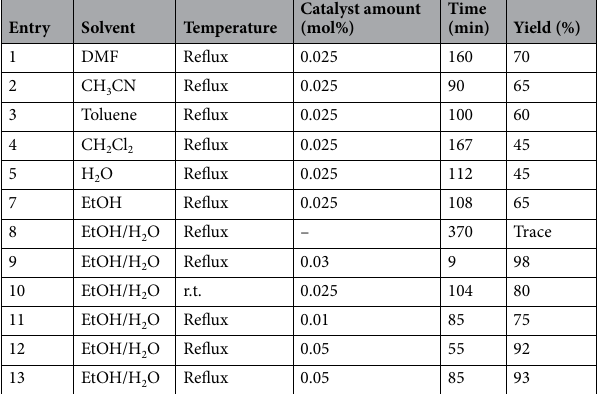
Table 1. Investigating the effect of solvent on the synthesis of derivative 12a via